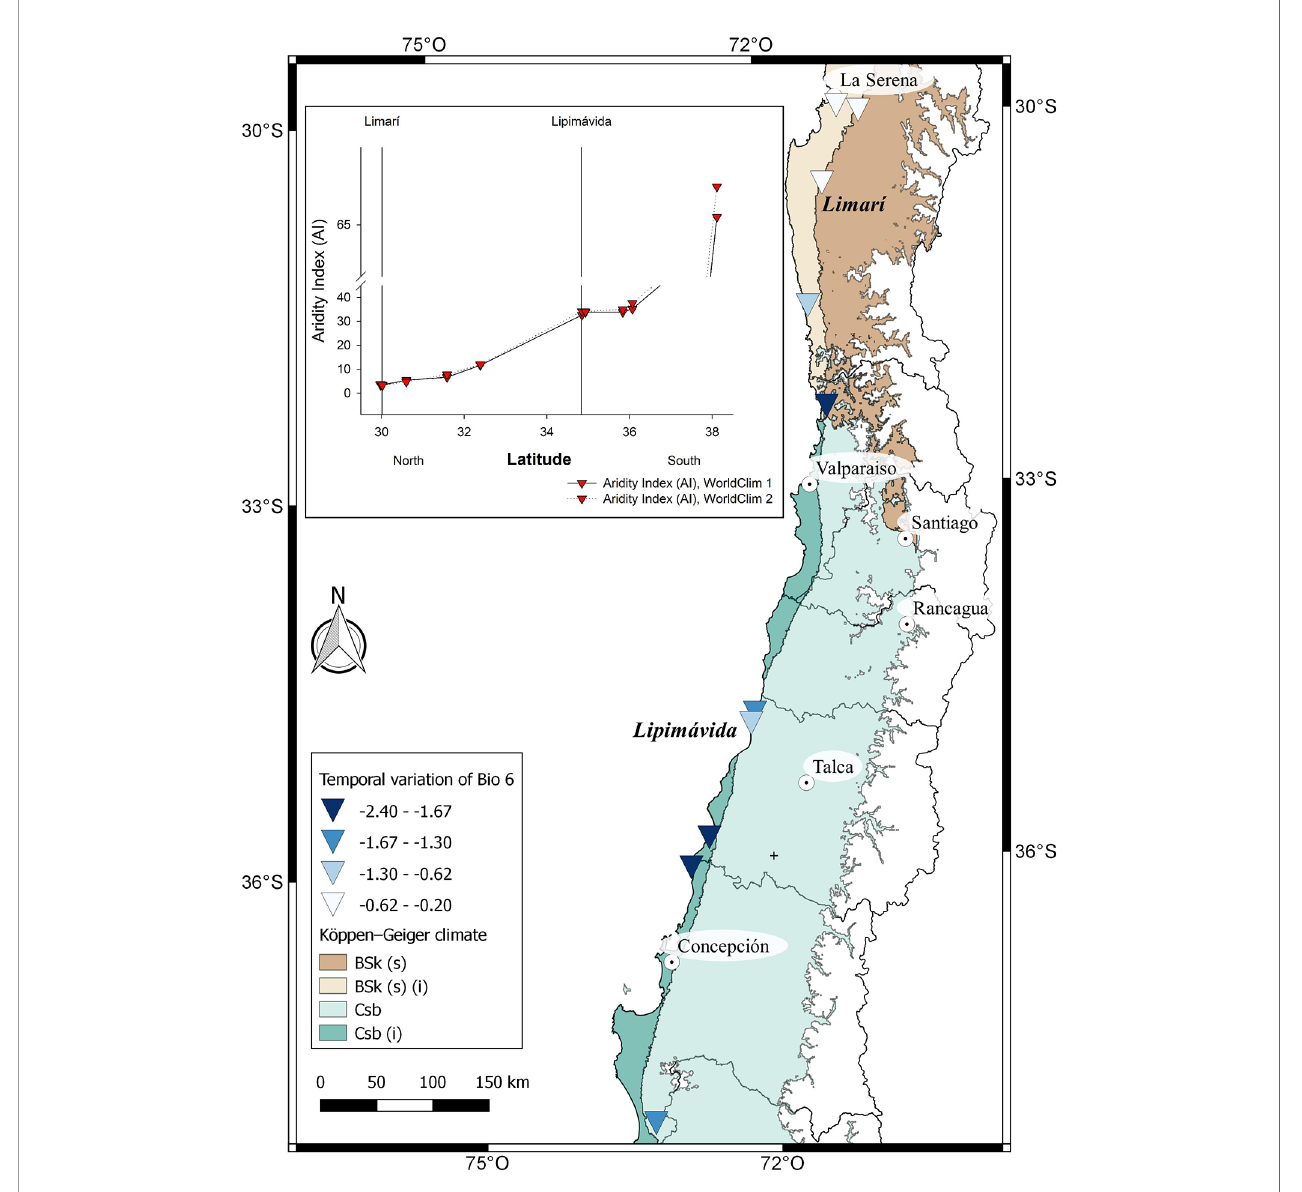
FIGURE 5 | Climatic characterization of cultivated localities of V. pubescens distributed from North to South. The comparison of Bioclimatic variable 6 (Min temperature of coldest month) between WorldClim 1 and 2 for each locality is shown in the map. In the insert, De Martonne Aridity Index (AI) for each locality. On the X axis, the localities of Limar ı ́ and Lipima ́ vida are marked as reference, as previously shown in Figure 1